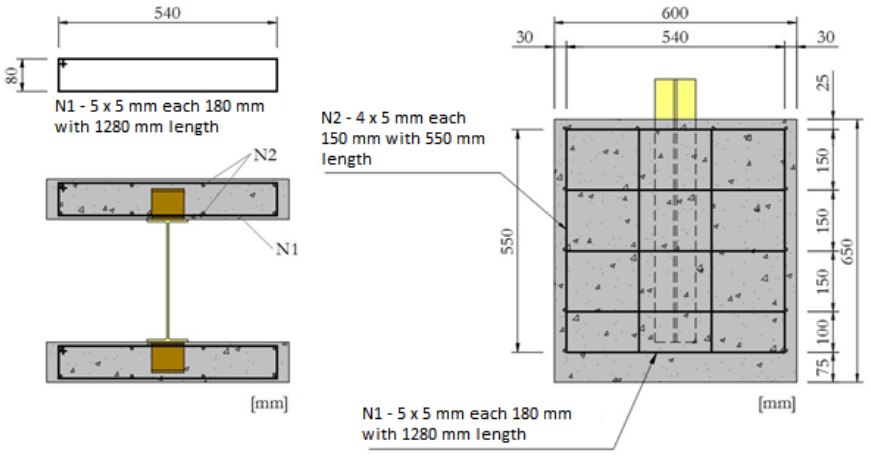
Figure 5. Concrete slab dimensions for push-out test models.